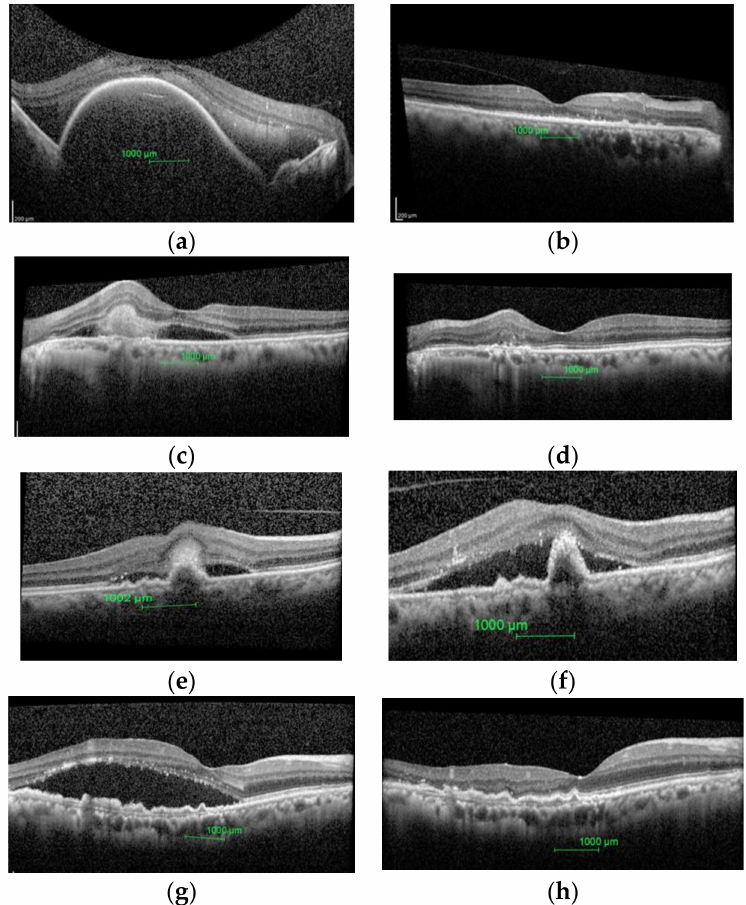
Figure 2. Pre-treatment and post-treatment images of polypoidal choroidal vasculopathy (PCV) eyes obtained by SD-OCT. ( a ) Pre-treatment PCV eye with large PED and hypo reflective area attached to it. ( b ) Post-treatment with no PED. ( c ) Pre-treatment PCV eye with SRF and sub-retinal hemorrhage. ( d ) Post-treatment with no SRF and resolved sub-retinal hemorrhage. ( e ) Pre-treatment PCV eye with multiple PED with SRF and sub-retinal hemorrhage. ( f ) Post-treatment with SRF, multiple PED with medium reflective areas attached to the central PED. ( g ) Pre-treatment PCV eye with SRF and multiple hyper reflective spots. ( h ) Post-treatment with no SRF and few hyper reflective